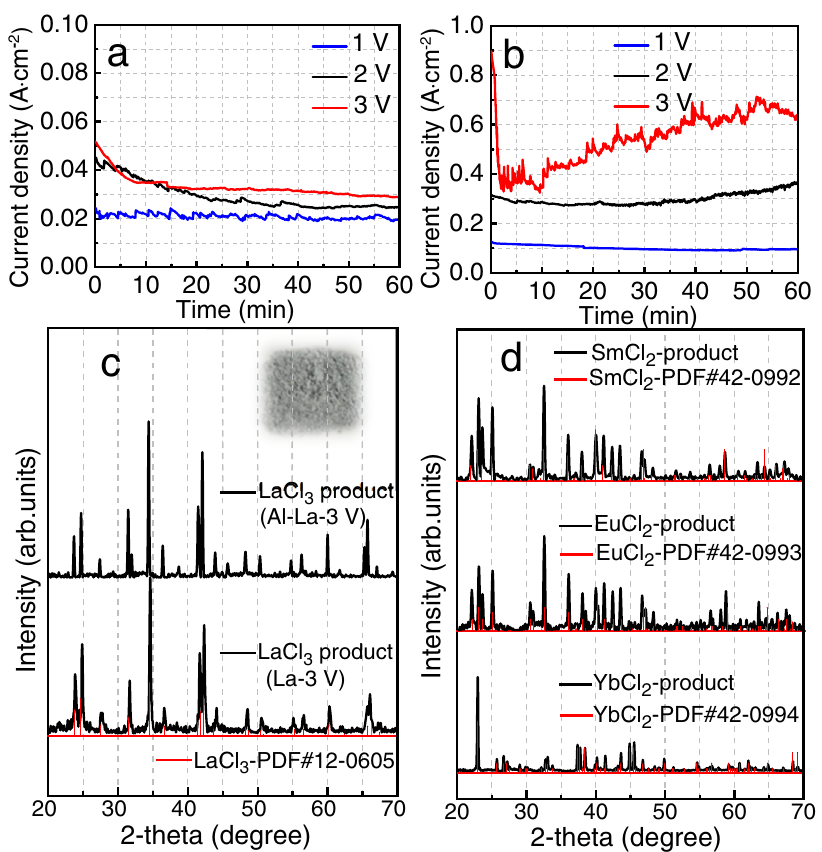
Fig. 4 Anodic processes of lanthanides. Current vs. time plots at three electrode potentials in NaAlCl 4 melt at 453 K using as the anode a La and b Al-La alloy. c XRD patterns of IAP anode precipitates for La and Al – La anodes; the inset is a photo of the LaCl 3 product. d XRD patterns of precipitates from Sm, Eu, and Yb